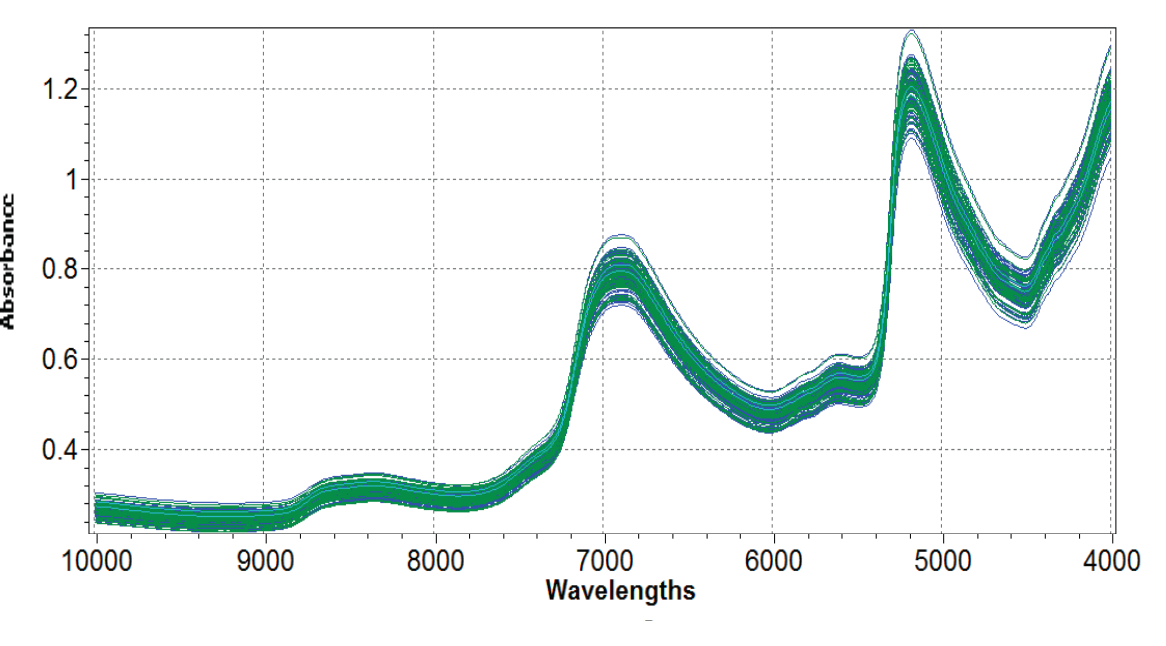
Figure 1. NIR raw absorbance spectra of fresh apple leaves. NIR-Cal ® software automatically subdivides original spectra in calibration (blue) and validation (green)